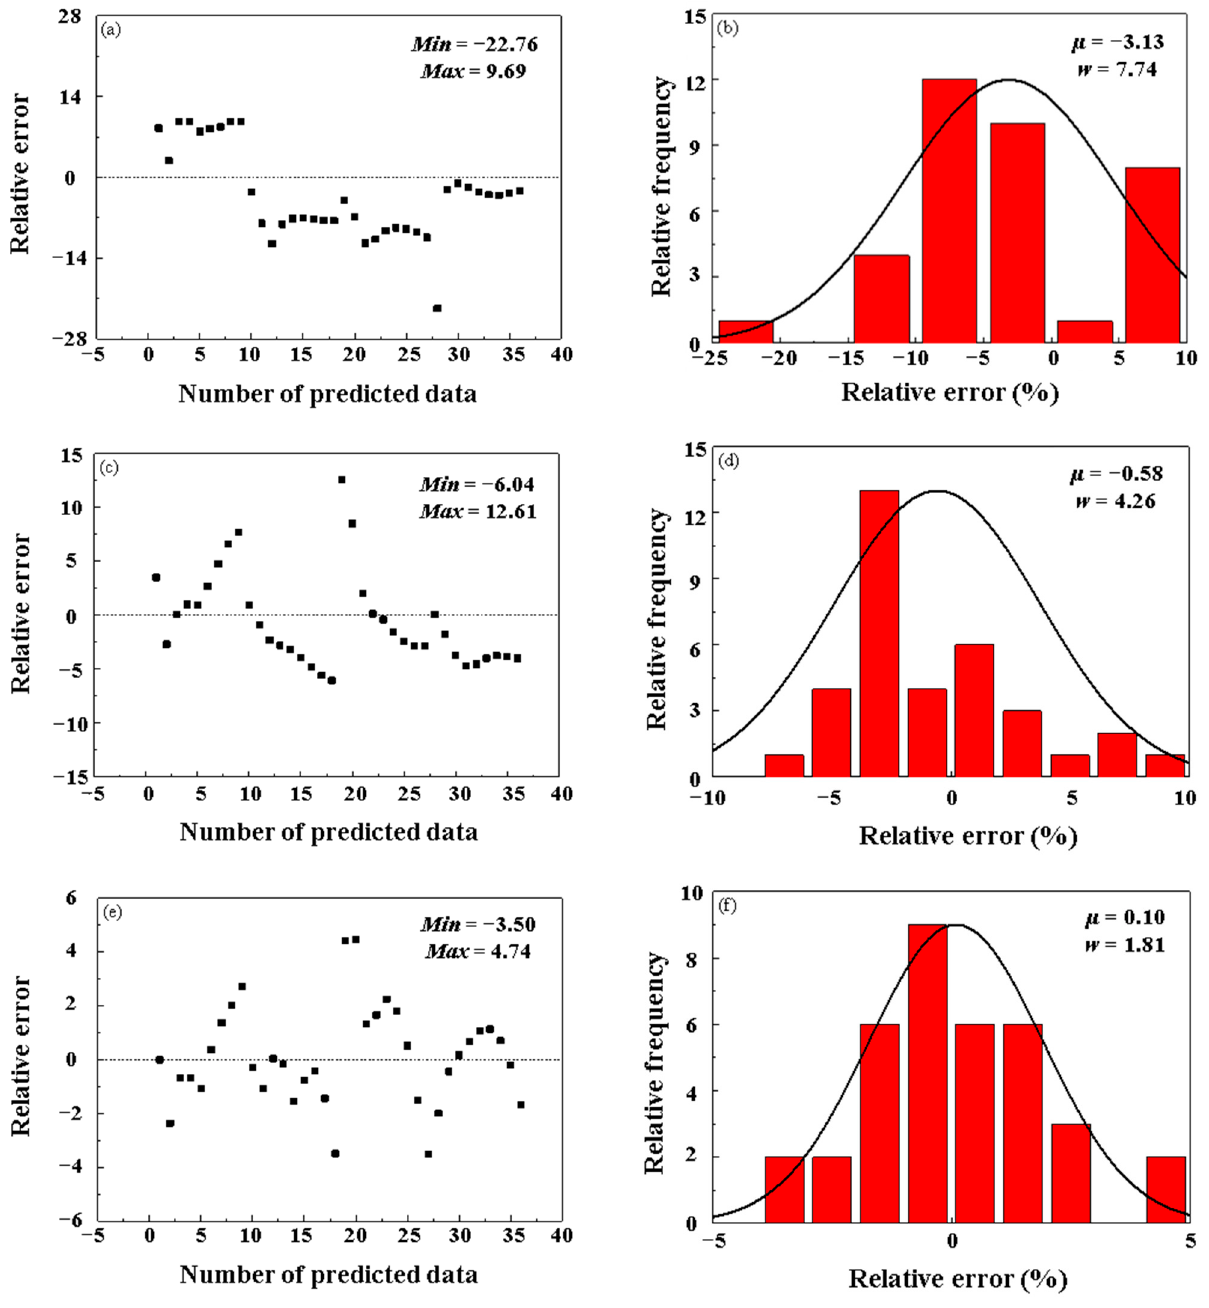
Figure 11. Distributions of the relative errors of the testing data by ( a , b ) the semi-physical model with improved Arrhenius-Type, ( c , d ) BP-ANN, and ( e , f ) PSO-BP integrated model.